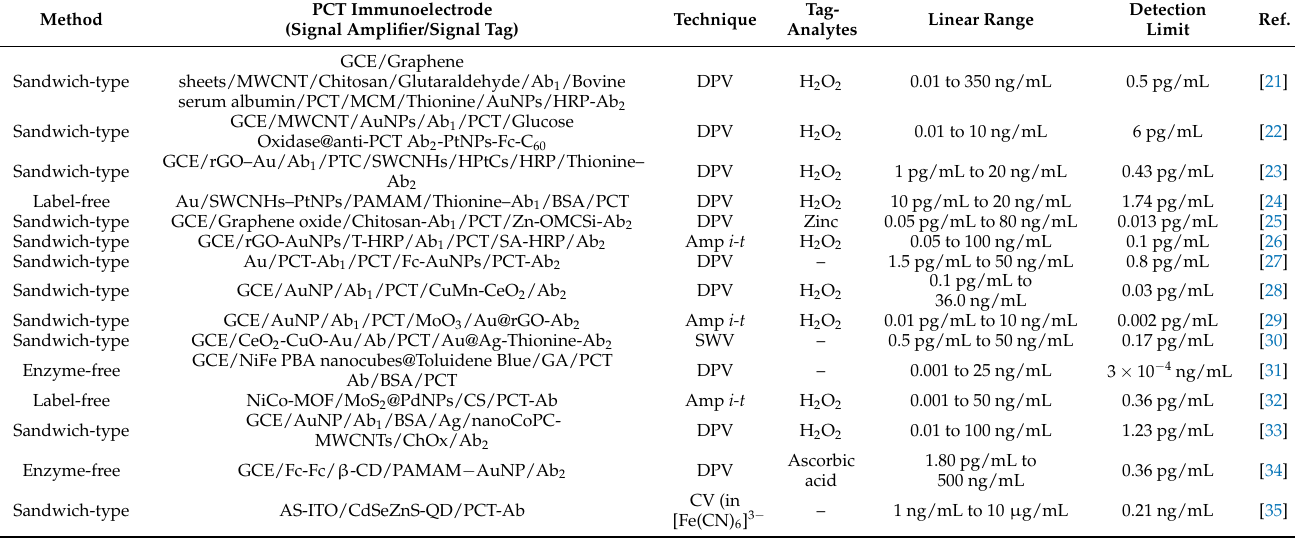
Table 1. Comparison of the electroanalytical performances of various PCT electrochemical immunosensors available in the